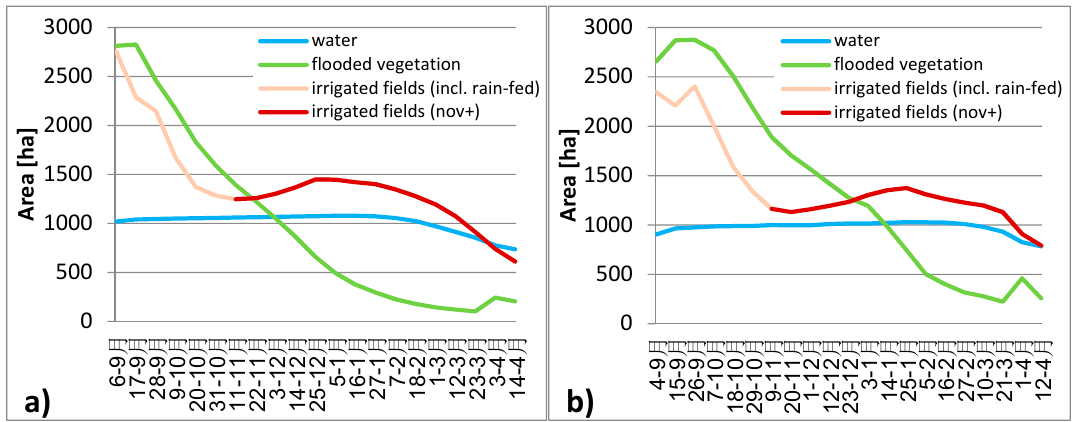
Figure 11. Time series of the wetland area per class for ( a ) 2013–2014 and ( b ) 2014–2015: open water (blue), flooded/floating vegetation (green), irrigated fields (dark red), and rain-fed cultivation (light red).